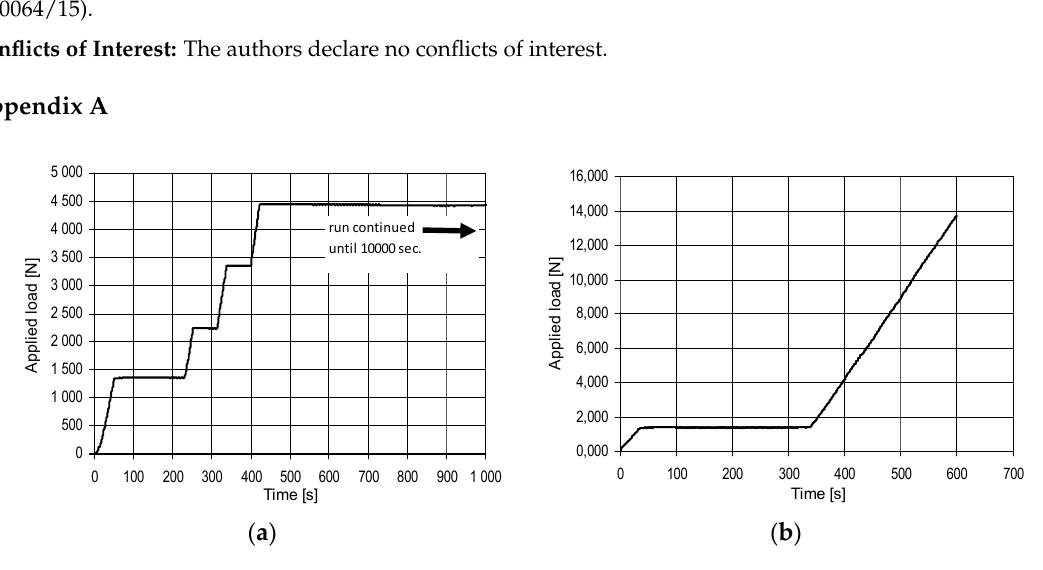
Figure A1. Load increase in ( a ) abrasion tests and ( b ) scuffing tests.